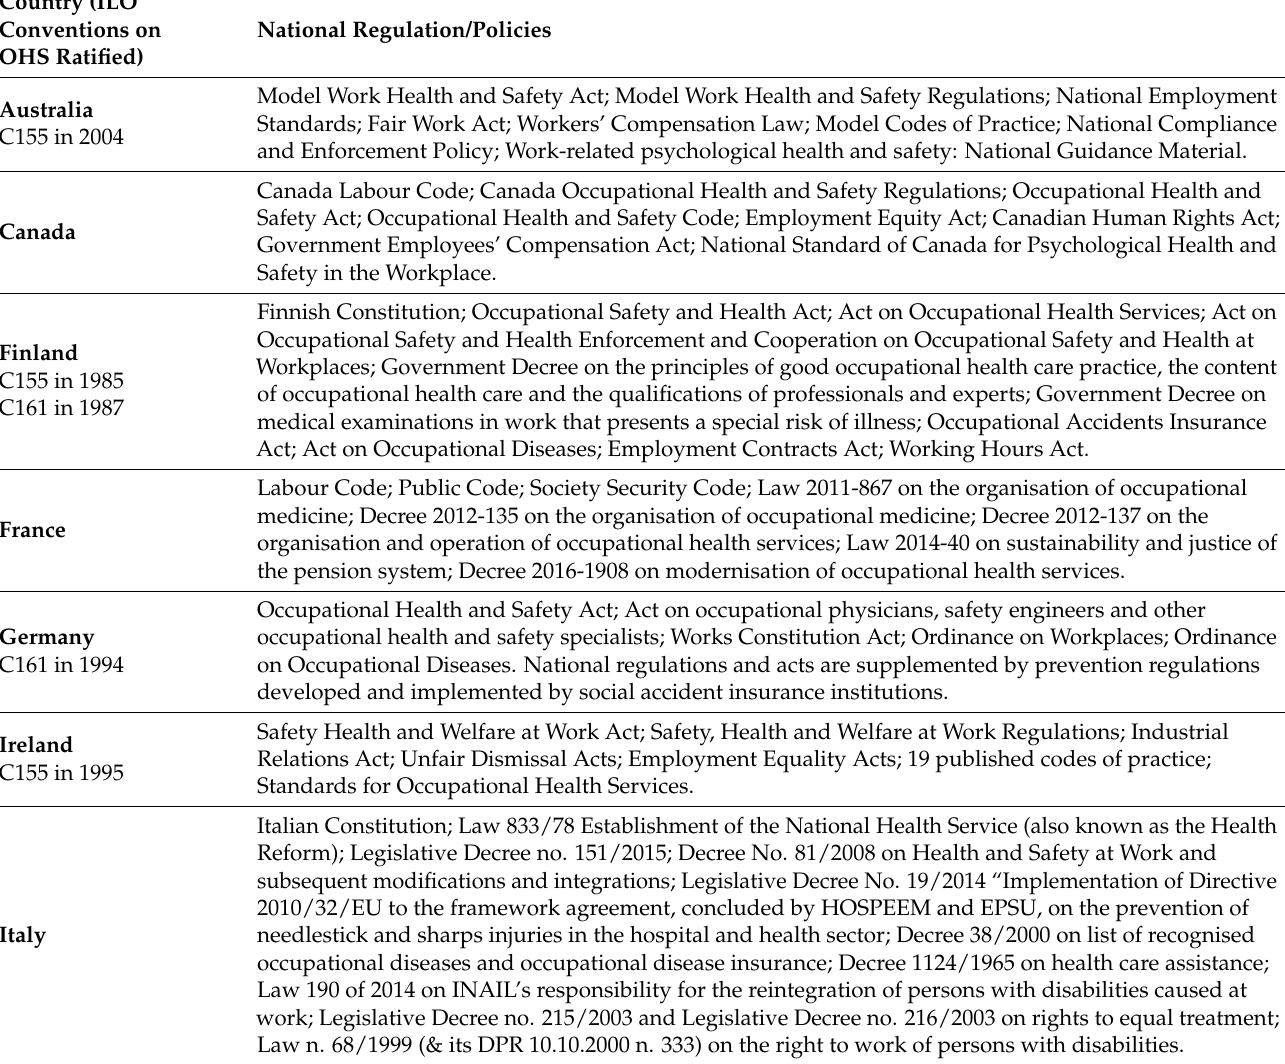
Table 2. Legal and policy context relating to occupational health services (OHS), psychosocial risks and mental health at